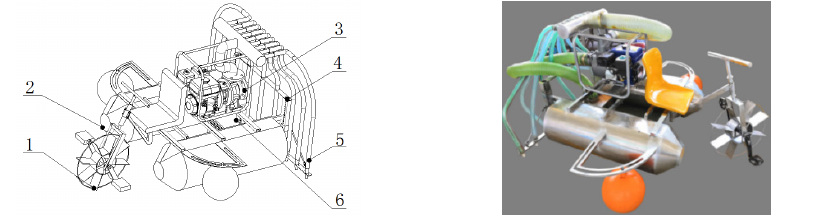
Figure 1. The lotus root digging machine: (1) driving component, (2) frame, (3) gasoline engine pump set, (4) hydraulic flushing device, (5) pipelines, (6) reservoir. Table 3. Technical parameters of the lotus root digging